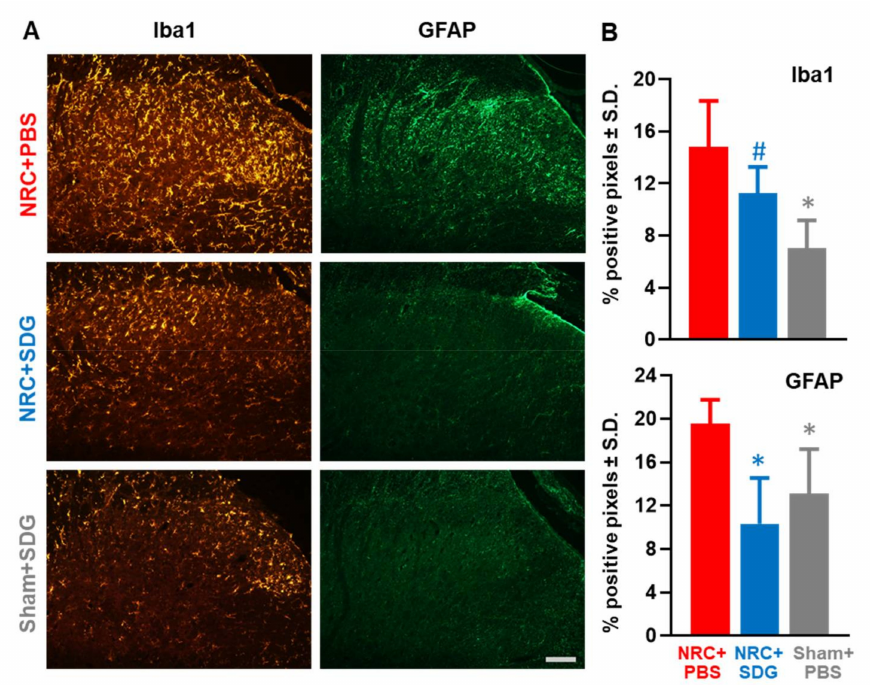
Figure 6. ( A ) SDG treatment after painful NRC reduces spinal astrocytic but not microglial activation, as evident in tissue sections from representative rats (scale is 100 µ m and applies to all panels).( B ) SDG treatment does not alter spinal Iba1 levels after NRC compared to vehicle treatment, with levels significantly elevated ( # p = 0.022) over sham-treated rats. Spinal Iba1 expression in the Sham + SDG group are significantly lower (* p = 0.0012) than the NRC + PBS group. After a painful NRC, spinal GFAP expression with SDG treatment is significantly reduced (* p = 0.003) compared to vehicle treatment. Similarly, spinal GFAP in sham-treated groups is significantly (* p = 0.03) lower than the vehicle treated